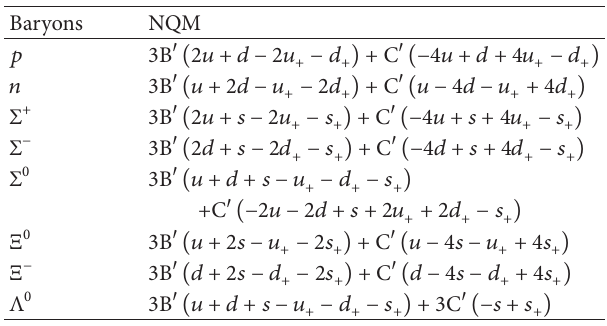
Table 7: Quadrupole moments of the octet baryons in NQM using the